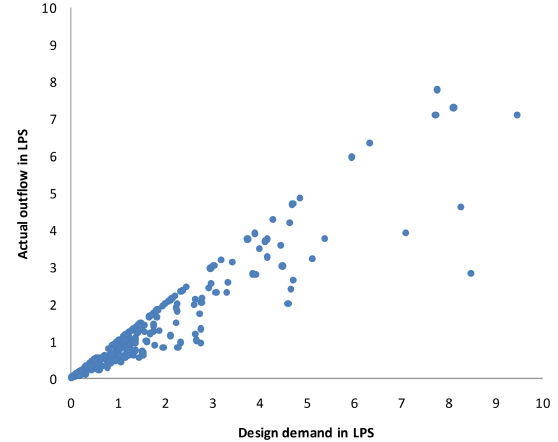
Figure 10. Actual outflow against design demand when there is no supply from reservoir ID